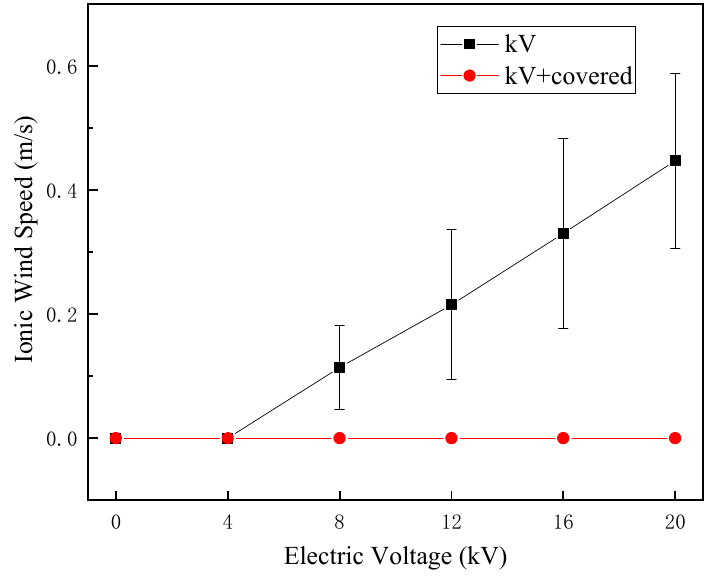
Figure 7. Changes of ion wind speed under HVEF.